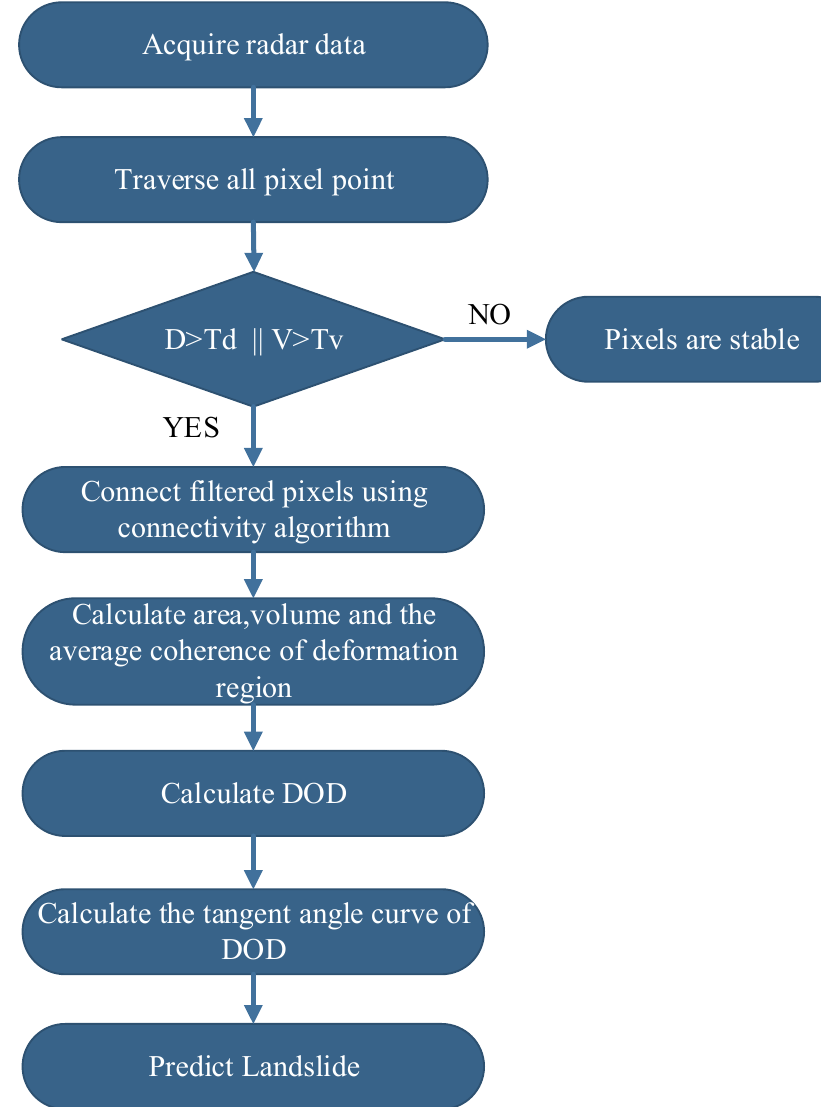
Figure 6. Flowchart of the landslide prediction